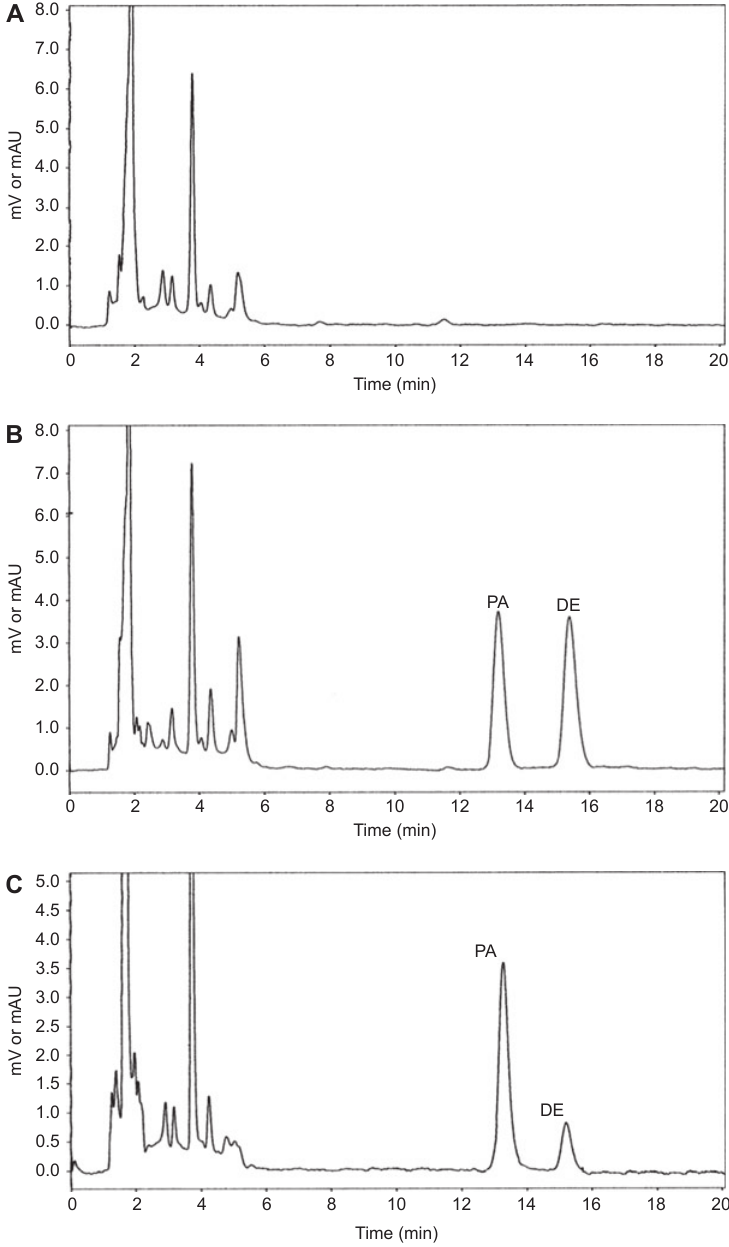
Figure 2 HPLC chromatograms of (A) a blank plasma, (B) a plasma spiked with 160 ng of DE and (C) 200 ng of the IS plasma sample obtained at 2 h after oral administration of 75 mg of imipramine from a healthy volunteer, IS 200 ng. (For all chromatograms, 1 ml plasma samples were